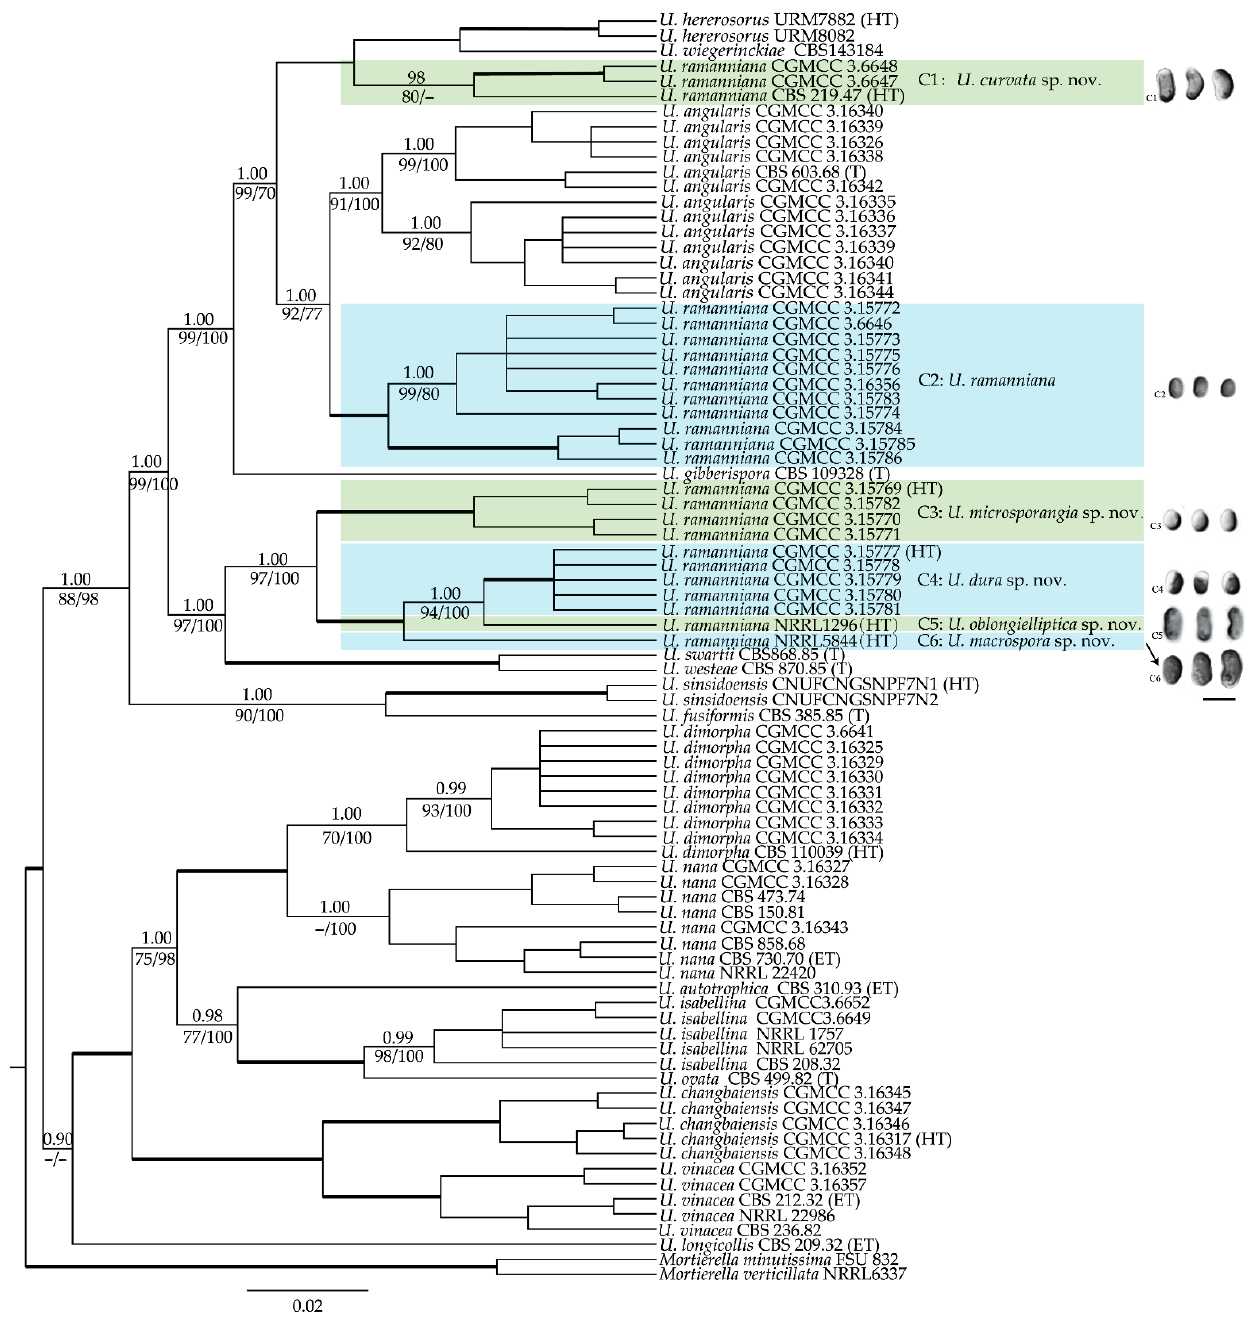
Figure 1. Phylogenetic tree for Umbelopsis based on a combined data matrix comprised alignments of nSSU, ITS, nLSU, act1 , MCM7 and cox1 generated from Bayesian analyses with Mortierella as outgroups. Values above the branches represent significant Bayesian posterior probability values (BPP ≥ 0.95), and values below the branches are maximum likelihood bootstrap proportion (MLBP ≥ 70%) and maximum parsimony bootstrap support values (MPBS ≥ 70%). Branches in bold indicate strong support (MLBP: 100%, MPBS: 100%, BPP: 1.00). Missing or weakly supported nodes (MLBP < 70%, MPBS < 70% or BPP < 0.95) are denoted by a minus sign “−”. The bar at the lower left indicates 0.02 expected changes per site. The new species are highlighted in green and blue. The sporangiospores of novel species established in this study are illustrated on the right side of the tree (scale bar = 5 µm) and correlated with each clade of the U. ramanniana complex using the same clade numbers. U. = Umbelopsis . T = ex-type strain, ET = ex-epitype strain and HT = ex-holotype strain.